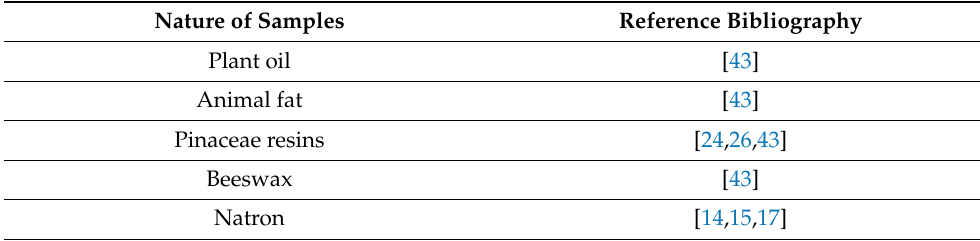
Table 5. Reference bibliography used for